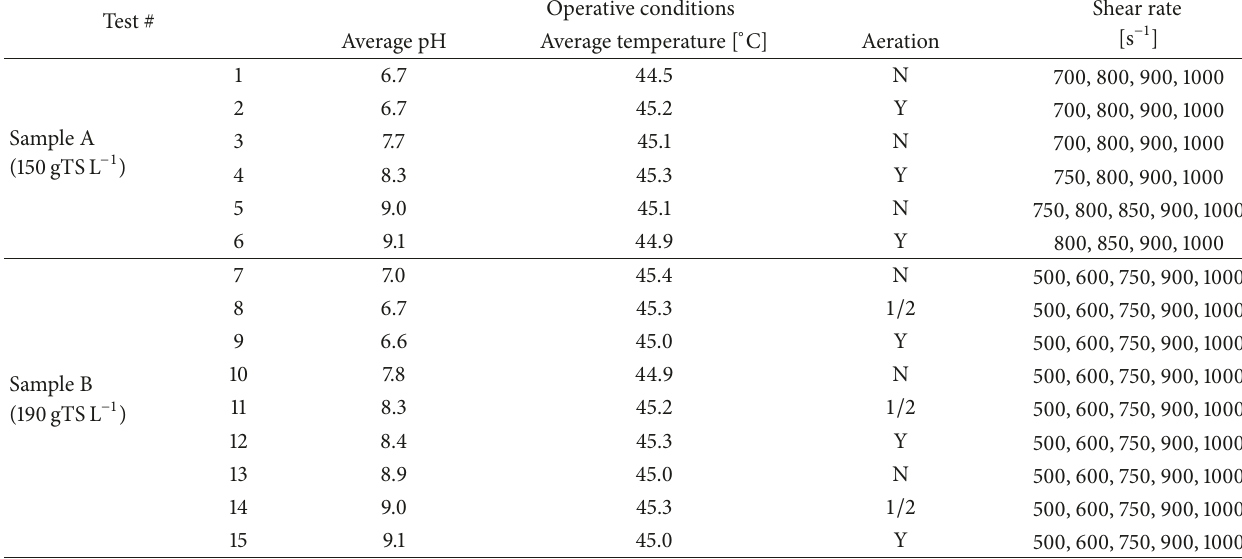
Table 1: Rheological tests performed: operative conditions.